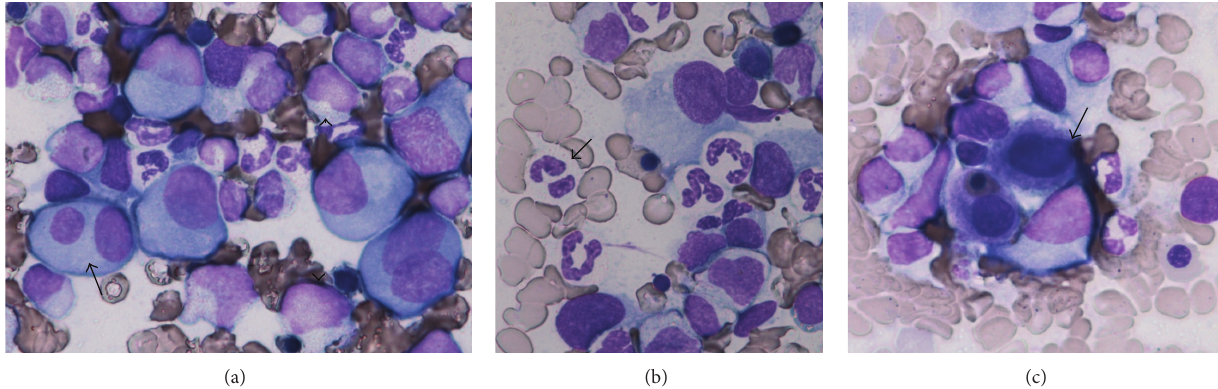
Figure 1: Bone marrow aspirate on second admission (Giemsa staining). A significant increase of monocytes (arrowhead) as well as plasma cells (arrow) was observed in bone marrow aspirates ((a), × 400 in magnification). Myelodysplastic change was also detected, showing as